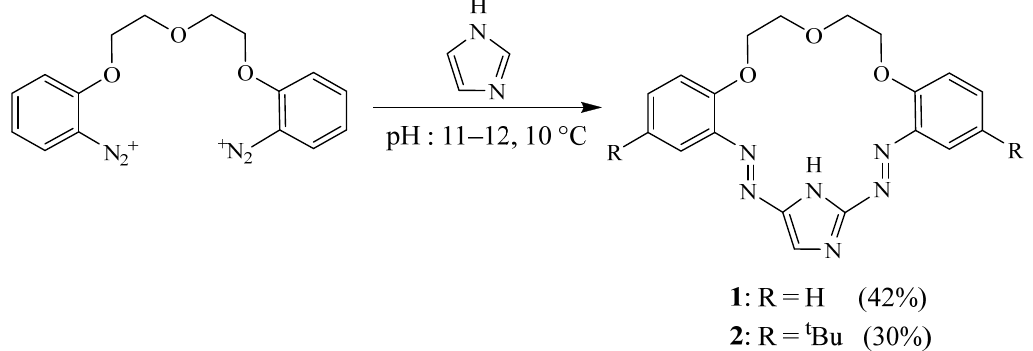
Figure 1. Final step of the synthesis of macrocycles 1 and 2 . (Reprinted with permission from ref. [15]. Copyright 2003 Elsevier).